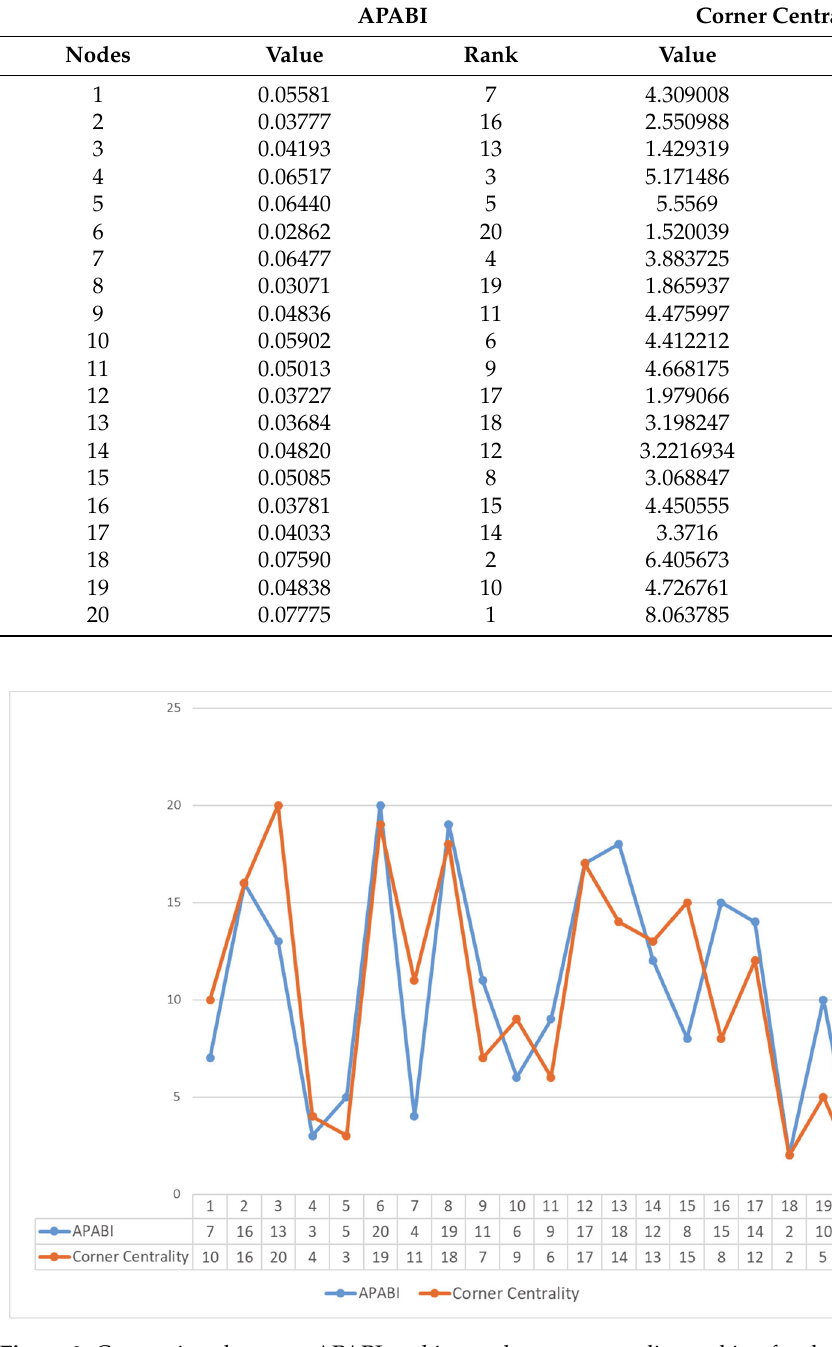
Figure 2. Comparison between APABI ranking and corner centrality ranking for the Football Team multiplex network. In this figure, we can see the degree of consensus between APABI and corner centrality. According to APABI, the leaders of the group are nodes 20 and 18, showing an overlap with the corner centrality measure.